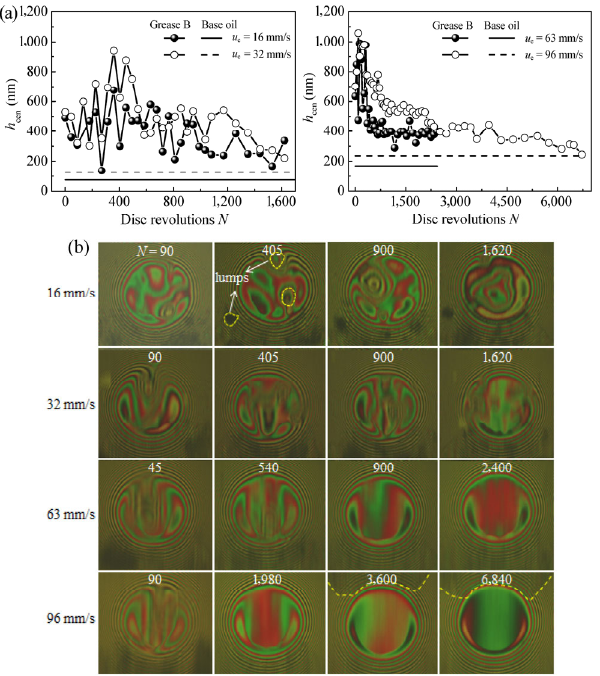
Fig. 7 Evolutions of EHL films against disc revolutions at different speeds, Grease B. (a) Variations of film thickness with disc revolutions; (b) interference images.